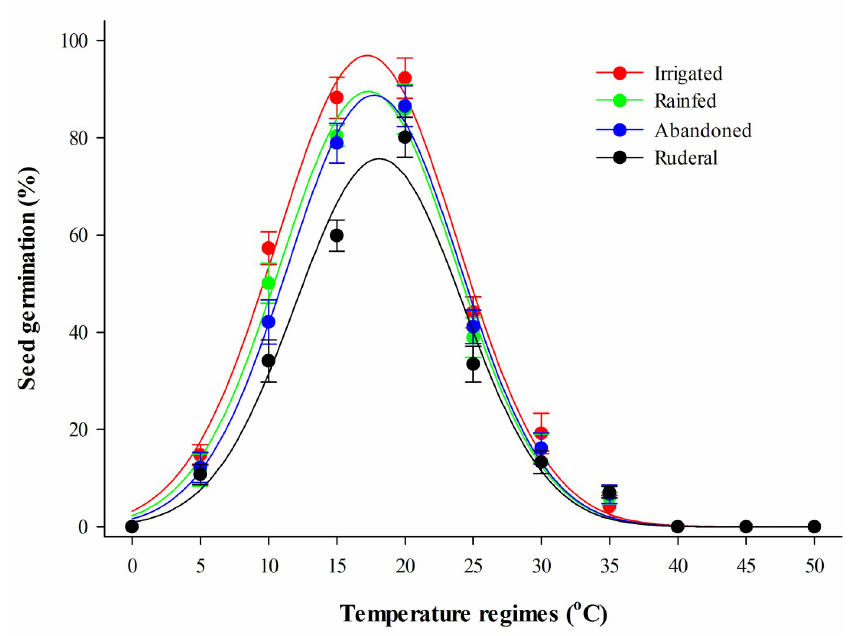
Fig 2. The influence of different constant temperatures on seed germination of Conyza stricta Willd. The vertical bars present standard errors of means (n = 10).